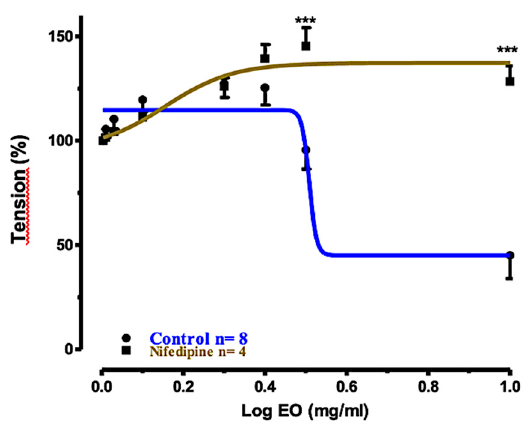
Figure 5. Concentration–response curves for the relaxant effects of EO S on rat tracheal rings precontracted with ACh (10 μ M): control and preincubated with nifedipine (30 μ M). *** p < 0.001.